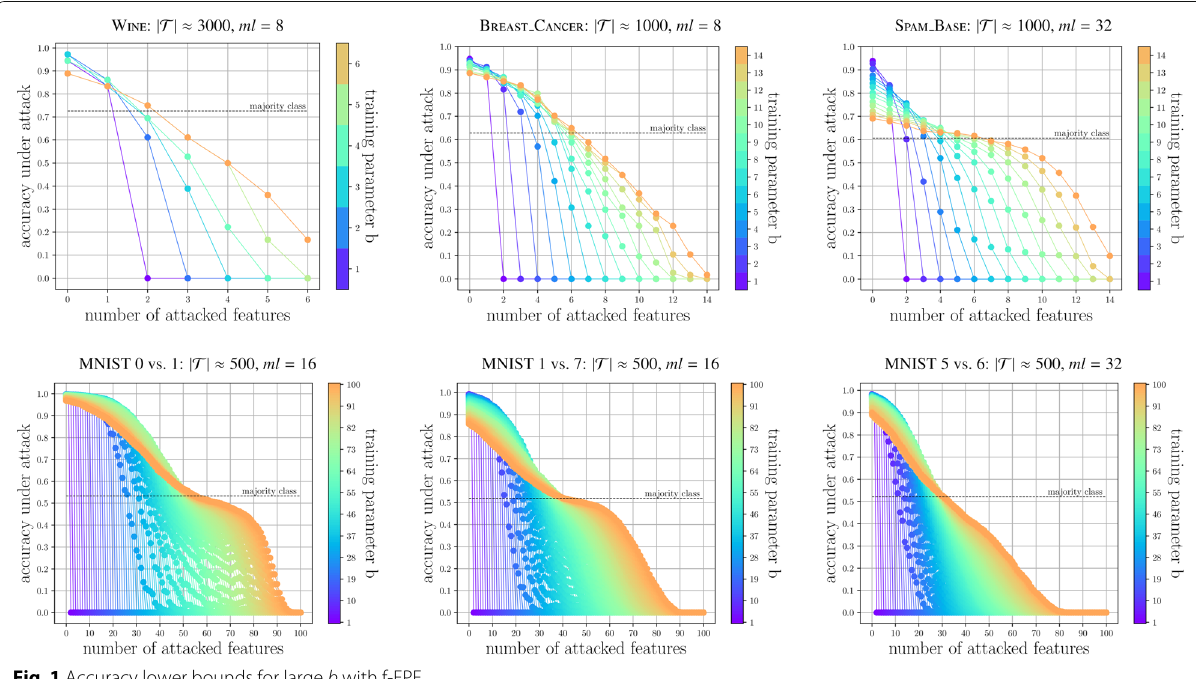
Fig. 1 Accuracy lower bounds for large b with f-FPF the computational cost required by BF exponentially increases when increasing k . As expected, the BF approach quickly becomes infeasible. The proposed C ASCADING strategy provides a 10 × speed-up that increases to 100 × when k = 3. This huge